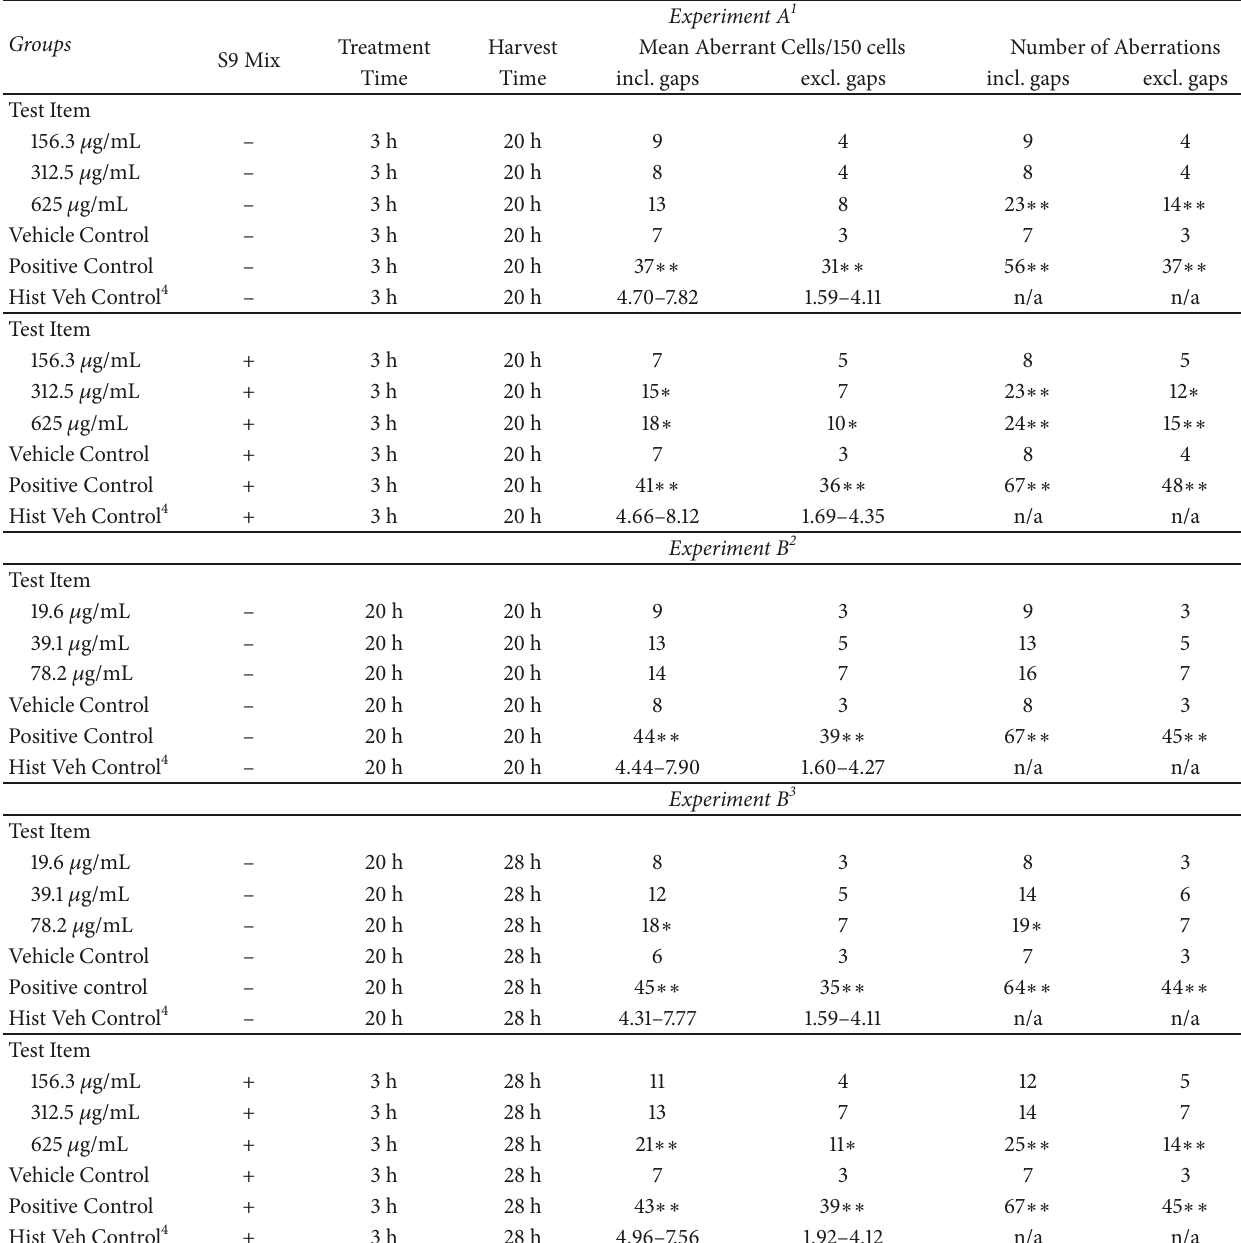
Table 3: Summary of chromosomal aberration test